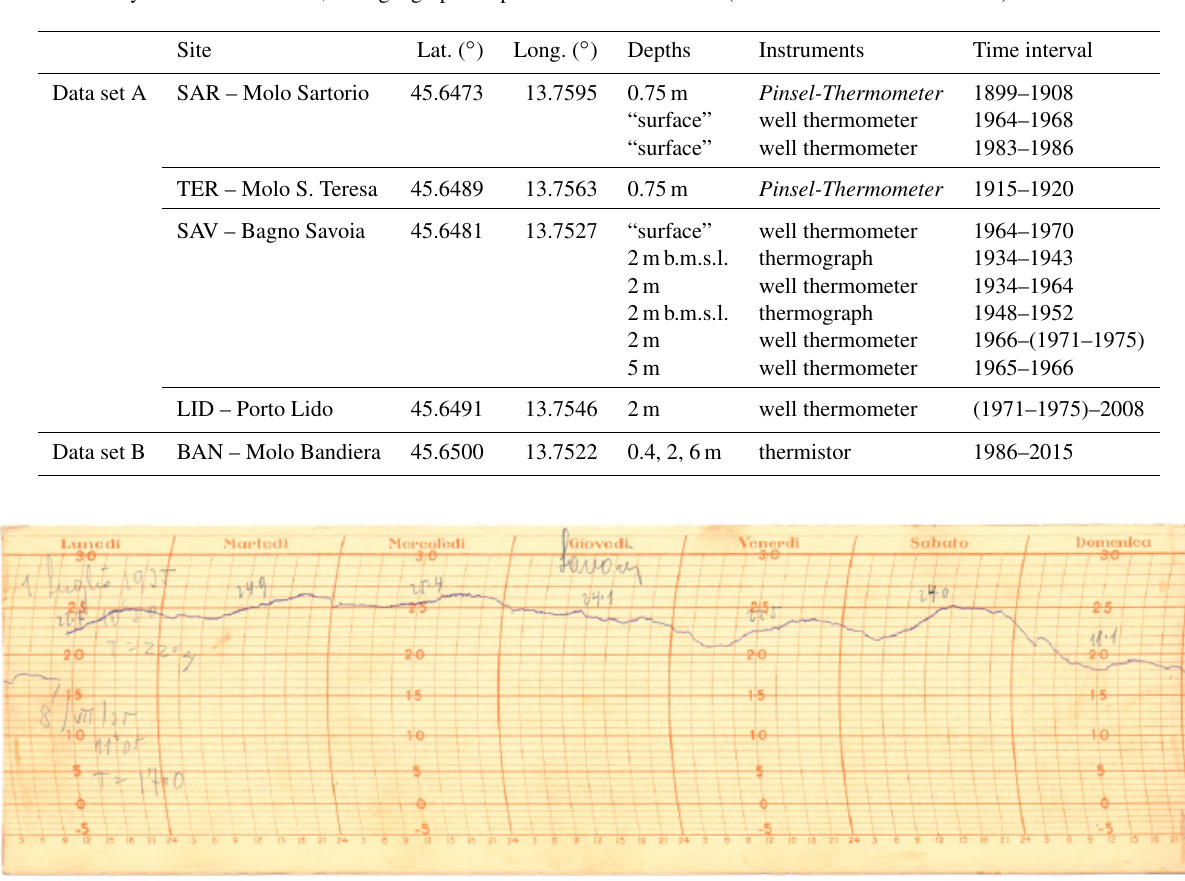
Table 1. Summary of observation sites, their geographical position and instruments (b.m.s.l.: below mean sea level).